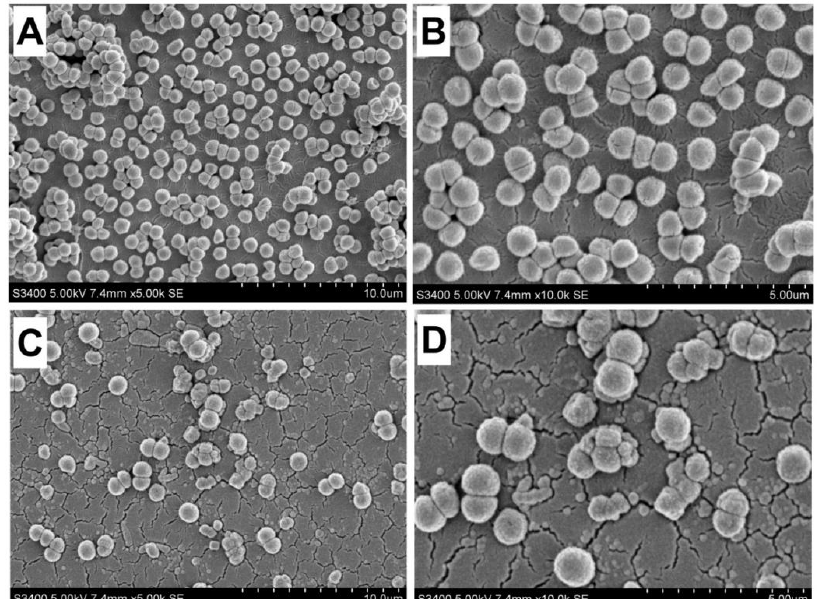
Figure 3. MRSA USA300 morphology investigated by scanning electron microscopy. ( A , B ) The control morphology of USA300 strain at 5000 and 10,000 times amplification of original magnification, respectively; ( C , D ) the morphology of USA300 strain treated by 4 µg/mL SA2 at 5000 and 10,000 times amplification of original magnification, respectively.